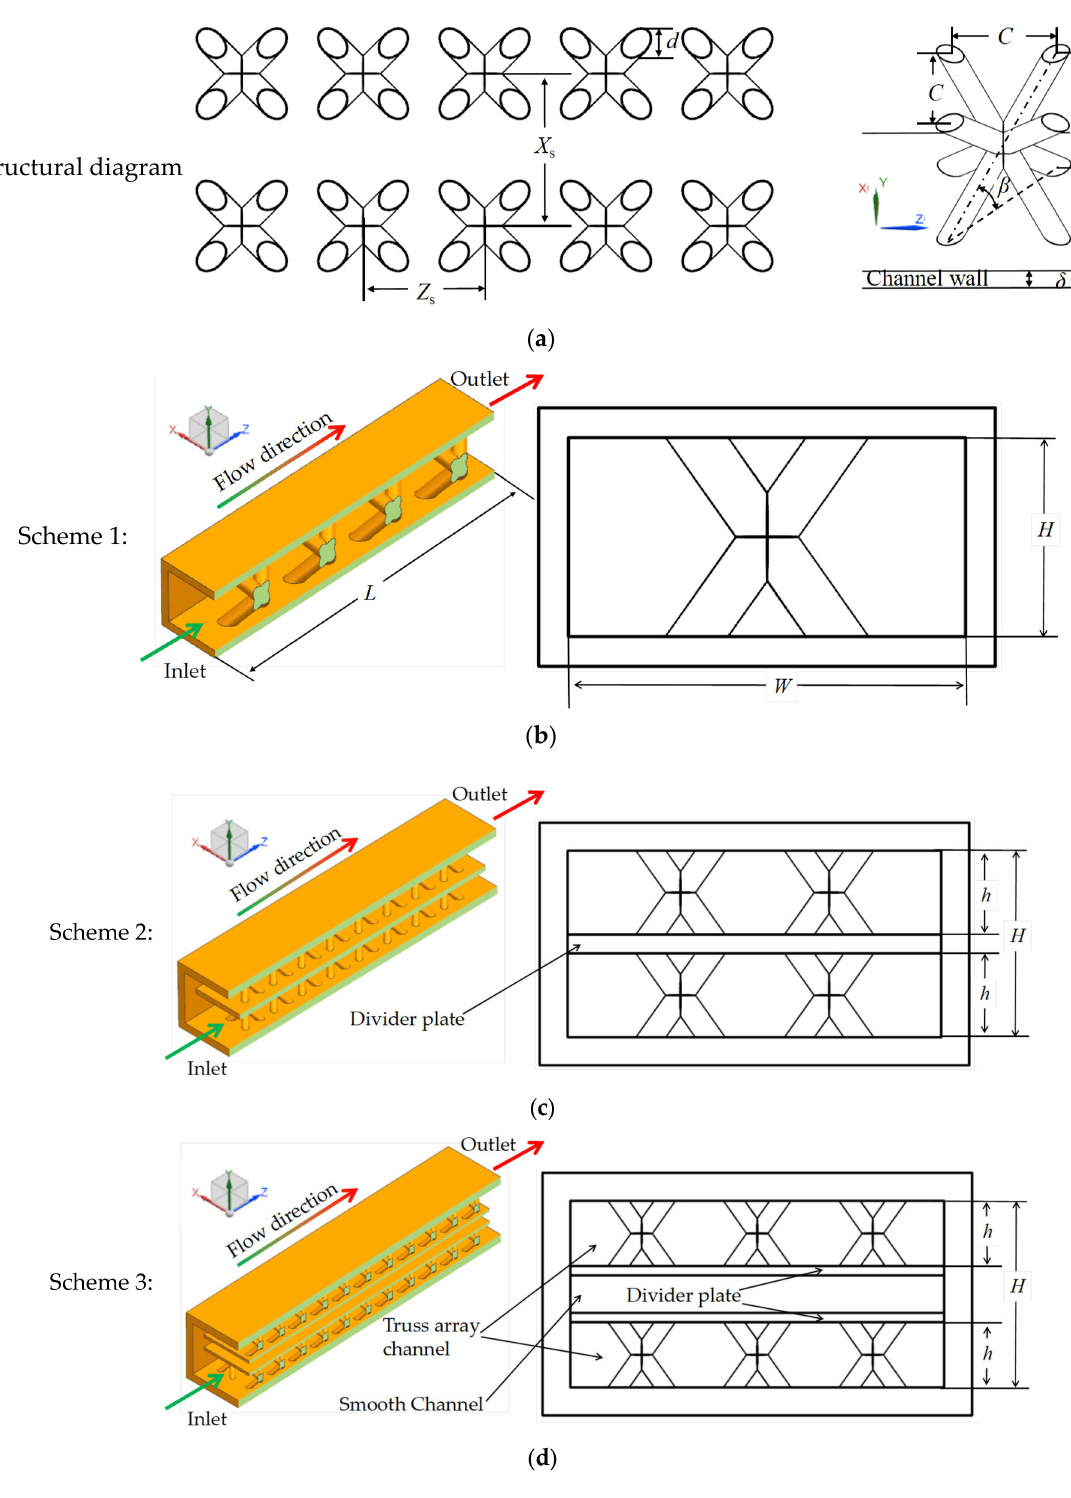
Figure 1. Research object: ( a ) structural diagram; ( b ) Scheme 1: single channel; ( c ) Scheme 2: two subchannels; ( d ) Scheme 3: three